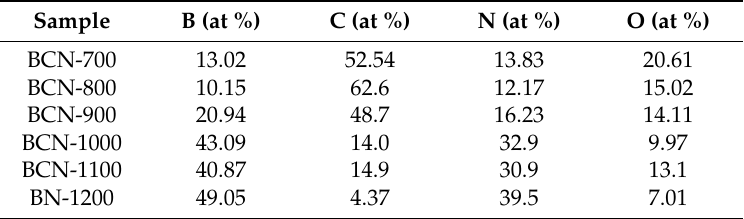
Table 1. Quantitative elemental compositions of the samples derived from XPS